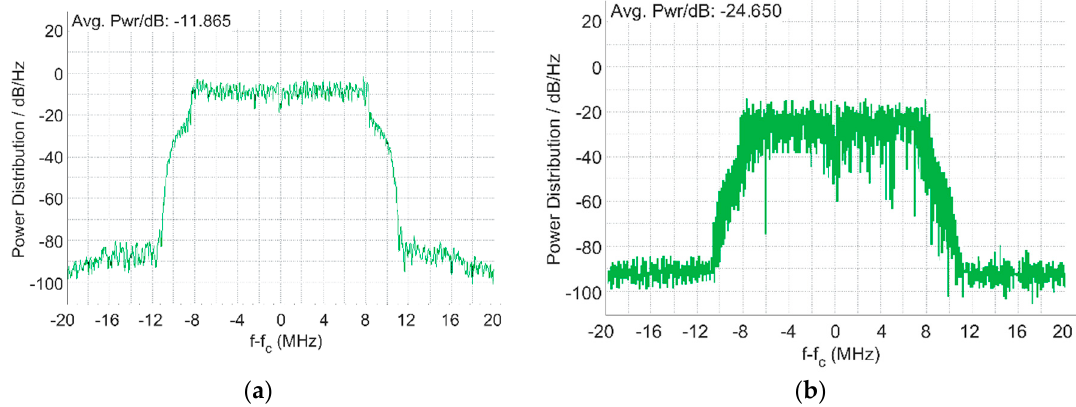
Figure 9. ( a ) Input spectrum of the integrated optical receiver with f c = 100 MHz. ( b ) Output spectrum of the integrated transimpedance amplifier.